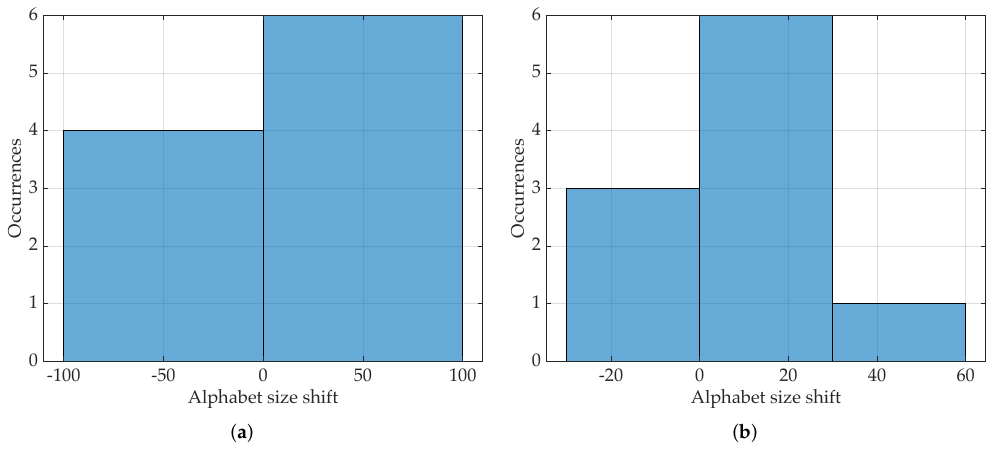
Figure 4. Distribution of the differences of the alphabet size for paths and cliques across the 10 datasets (after feature selection). A positive shift means that the stratified approach underperforms the non-stratified approach. ( a ) Paths. ( b )